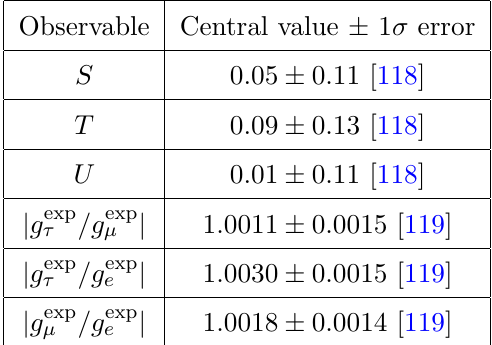
Table 3. The current experimental values and 1 (cid:27) errors for electroweak precision tests (see ap- pendix A) and universality (see section 3.4.1). The limits on the parameters S , T , and U are derived from a (cid:12)t to di(cid:11)erent electroweak precision data, see ref. [118] for more details. The correlation coe(cid:14)cients among the obervables S , T , and U are (cid:26) ST = 0 : 90, (cid:26) SU =